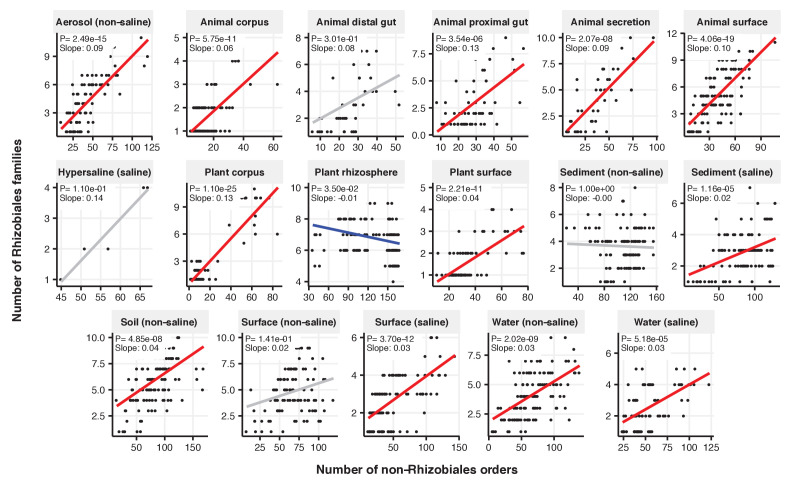
Focal-lineage diversity as a function of community diversity across biomes in Rhizobiales.Linear models are shown for the number of families per order (y-axis) as a function of community diversity (non-focal orders, x-axis) in each of the 17 environments (EMPO3 biomes). Only environments containing the focal lineage are shown. Significant positive diversity slopes are shown in red, negative in blue (linear models, p<0.05, Bonferroni corrected for 17 tests), and non-significant in grey.